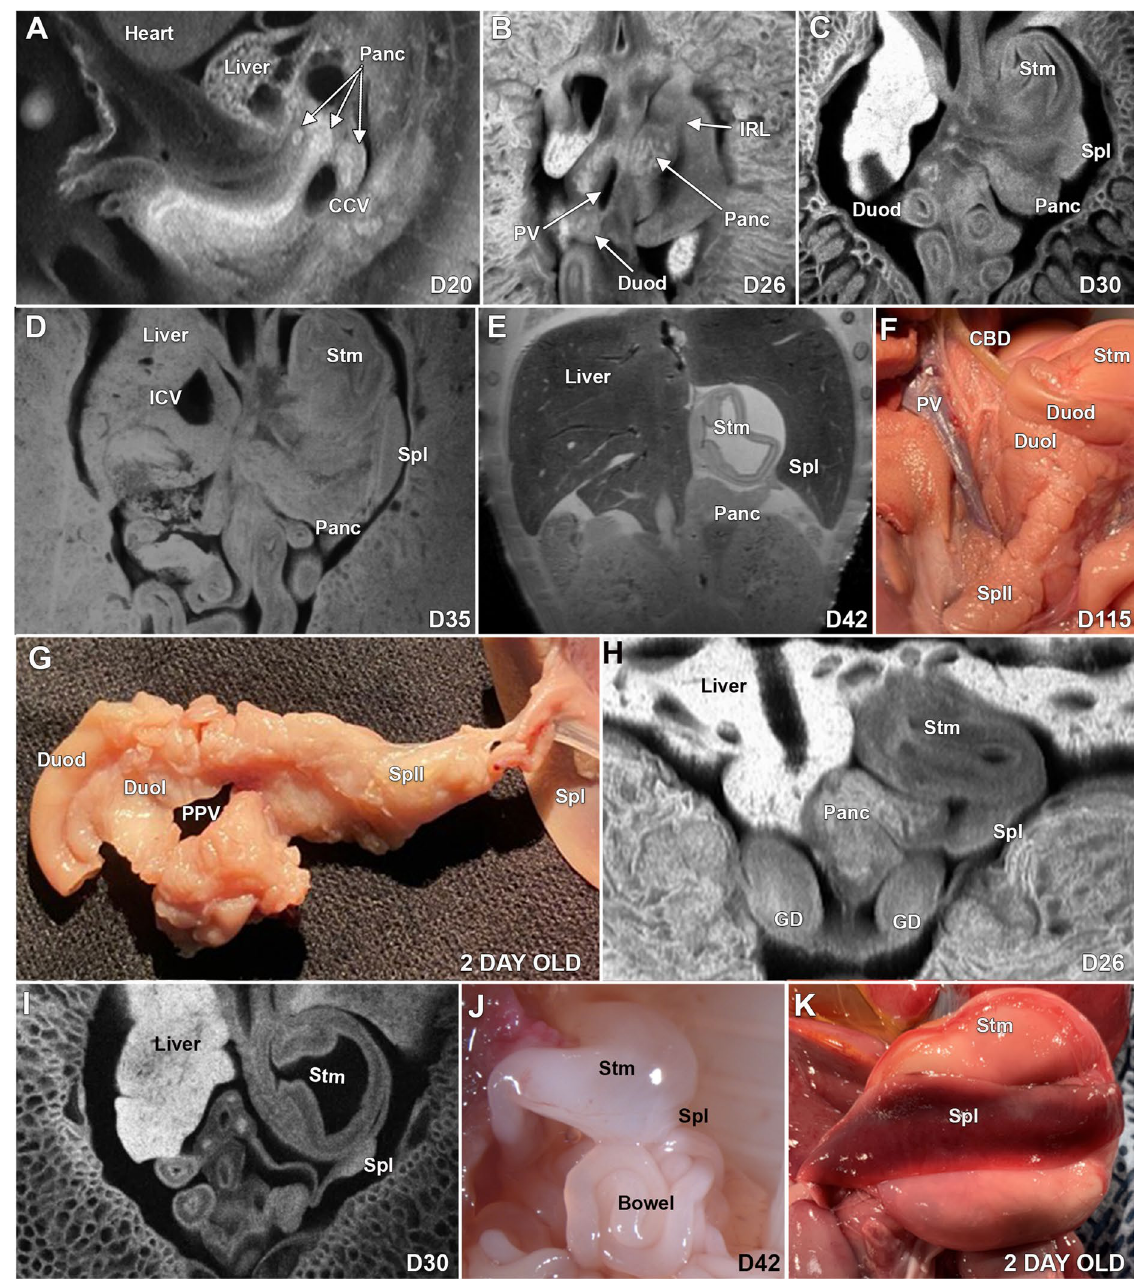
Figure 4. ECM, MRI, and gross images of the developing pancreas and spleen in the pig at D20 to 2 days of age. The early development of the pancreas ( A ) is seen at D20, and at D26. Image ( B ) shows the pancreas and its relationship to the portal vein. Image ( C ) shows the tail of the pancreas extending to the spleen at D30, and at D35, the pancreas appears more consolidated and well-formed ( D ), and at D42, the pancreas appears completely grossly formed ( E ). The in-situ dissection shows the pancreas surrounding the portal vein ( F ), and ( G ) shows the ex-situ dissected pancreas of a 2-day old pig. Images ( H and I ) show the spleen attached to the stomach at D26 and D30 respectively. Illustration (J) is an in-situ image of the pale spleen at D42 and ( K ) shows an in-situ spleen at 2 days of age. Panc-Pancreas, CCV-Caudal cardinal vein, PV-Portal vein, Duod-Duodenum, IRL-Ilenorenal ligament, ICV-Inferior caval vein, Stm-Stomach, CBD-Common bile duct, DuoL- Duodenal pancreatic lobe, Spll-Splenic pancreatic lobe, PPV-Path of the portal vein,